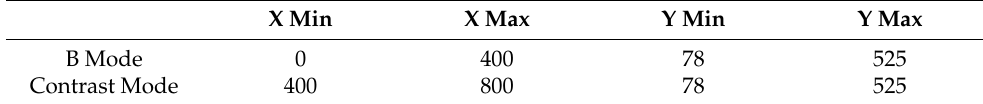
Table 2. Coordinates determined experimentally for B-mode and contrast